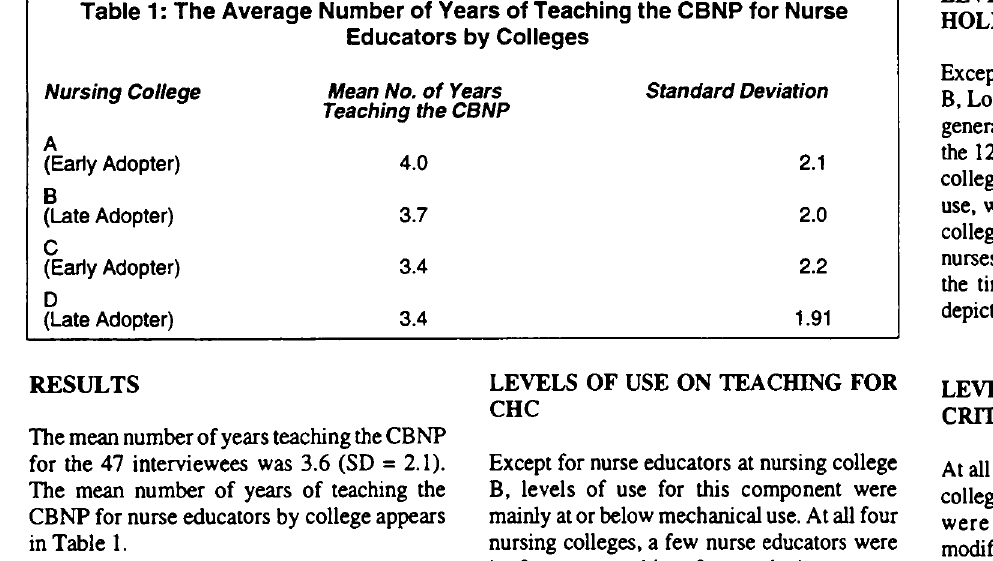
Table 1: The Average Number of Years of Teaching the CBNP for Nurse Educators by